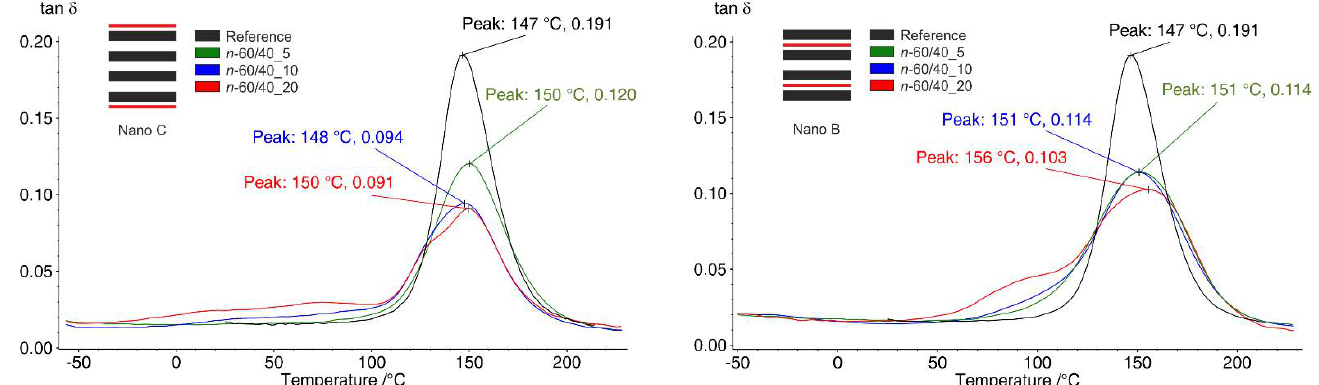
Figure 7. Comparison of tan δ curves of Nano C ( left ) and Nano B ( right ) laminate configurations.